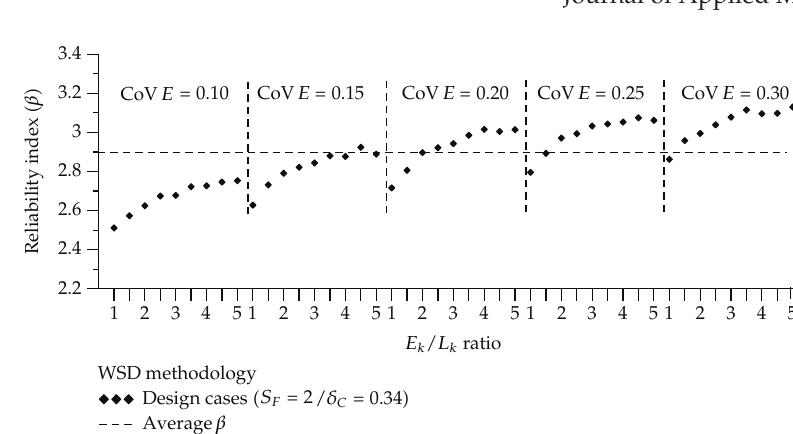
Figure 7: Reliability indexes of designs considering WSD methodology with S F (cid:8) 2 . 0 and δ C (cid:8) 0 . 34 (cid:5) 8 (cid:6) .